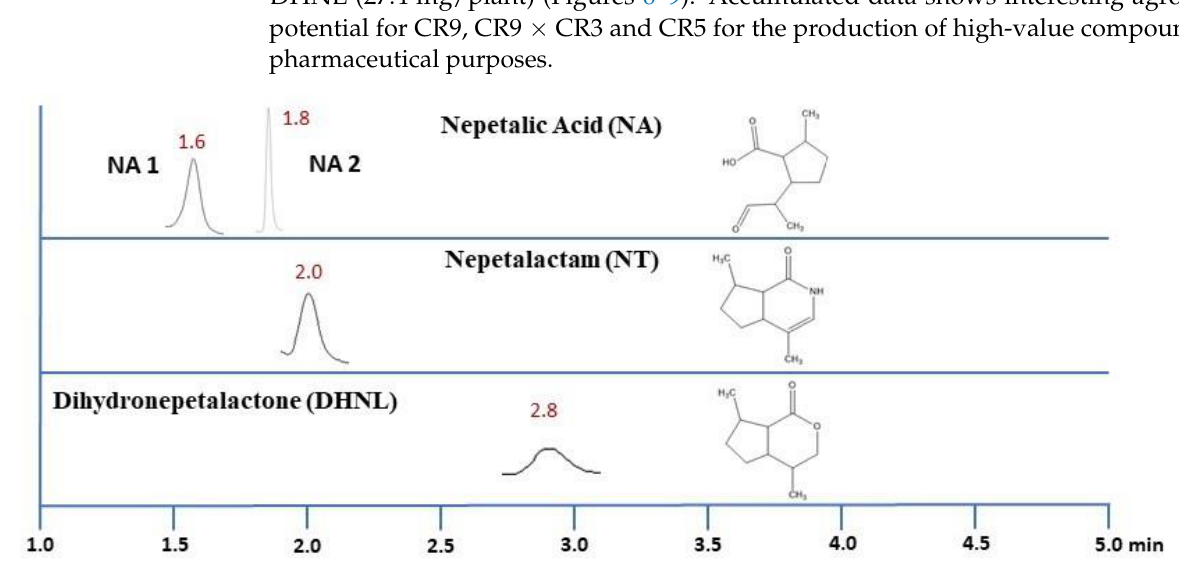
Figure 9. Representative chromatograms of Nepetalic Acid (NA), Nepetalactam (NT) and Dihy- dronepetalactone (DHNL) in CR3 by UHPLC-QqQ-MS/MS along with their chemical